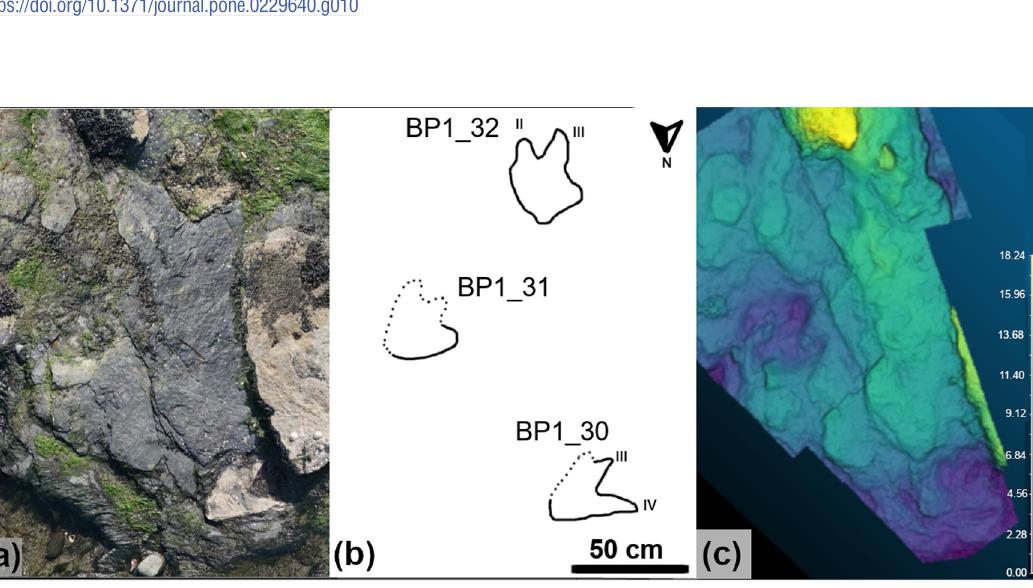
Fig 11. Overview of TA_1. TA_1 shown from (a) the model orthophoto, (b) as a line drawing, and (c) as a false color depth rendering. The three tracks composing the trackway present a variety of preservation styles, with BP1_30 and BP1_32 preserved as limestone casts and BP1_31 as a shallow impression. The impression can be seen in the orthophoto by looking both at subtle changes in vegetation and shading along the left margin and can be more clearly visualized using the false color depth rendering. The color scale of (c) is in units of